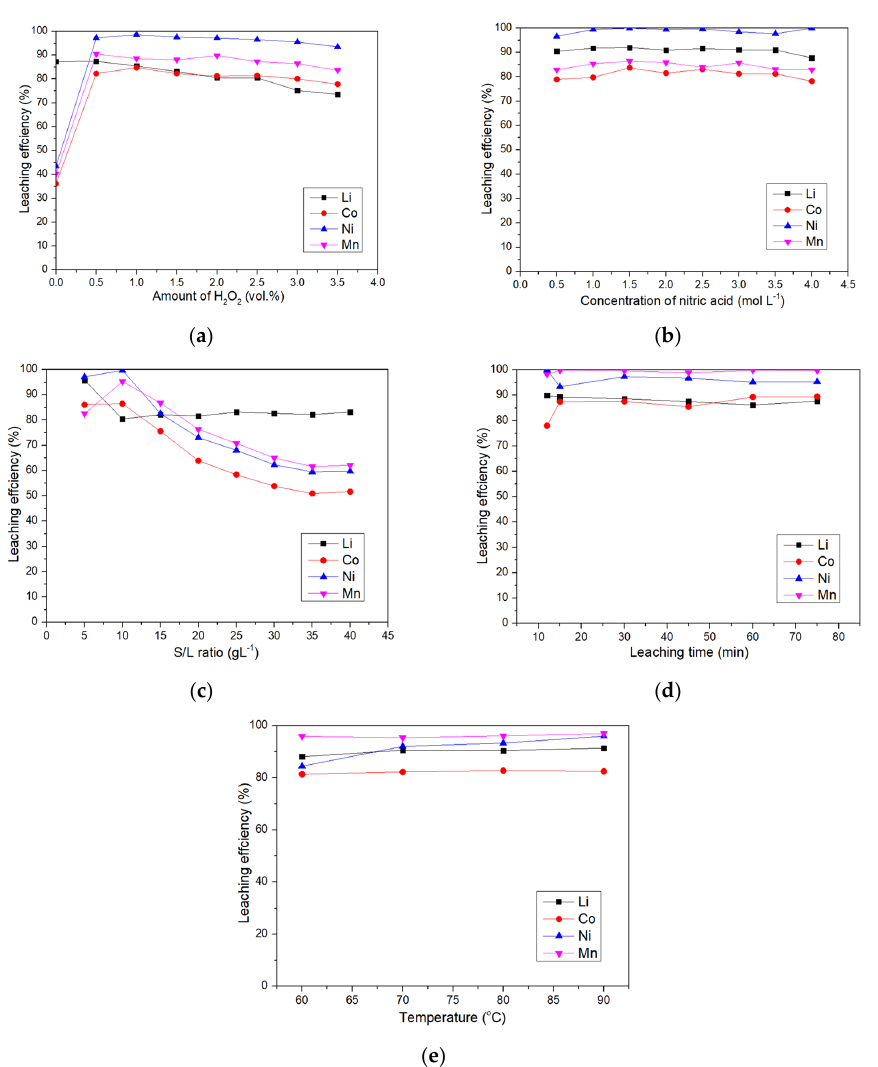
Figure 4. Effect of ( a ) amount of H 2 O 2 added, ( b ) acid concentration, ( c ) S/L ratio, ( d ) time, and ( e ) temperature on leaching efficiency of nitric acid. Table 5. Comparison of nitric acid leaching